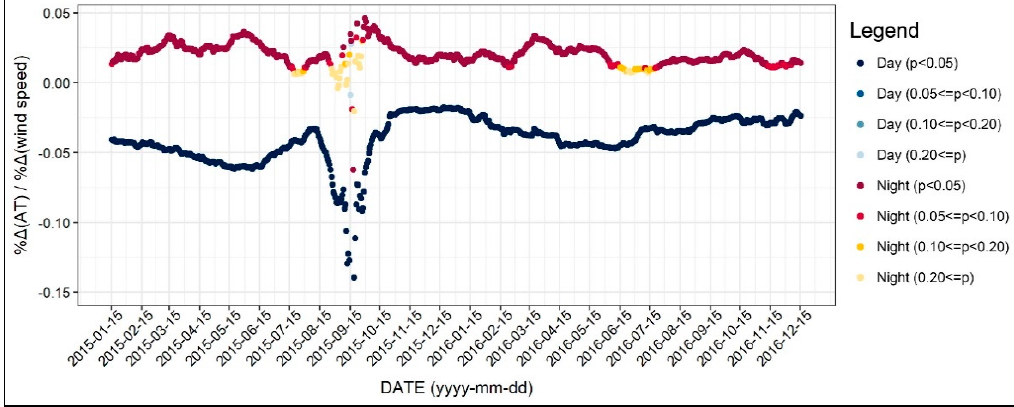
Figure 6. Changing patterns in the regression coefficients and their significances (wind speed).